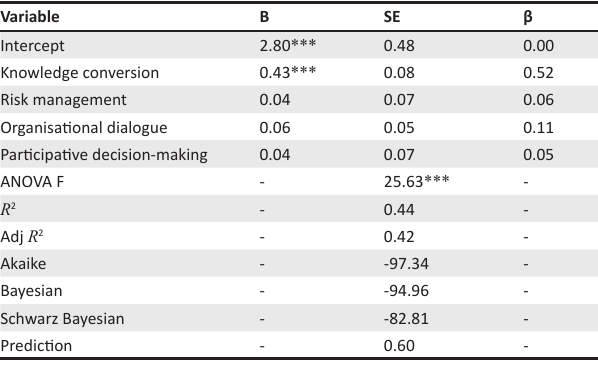
TABLE 6: Linear regression results for the effect of participative decision-making on social innovation (Hypnotises 6).